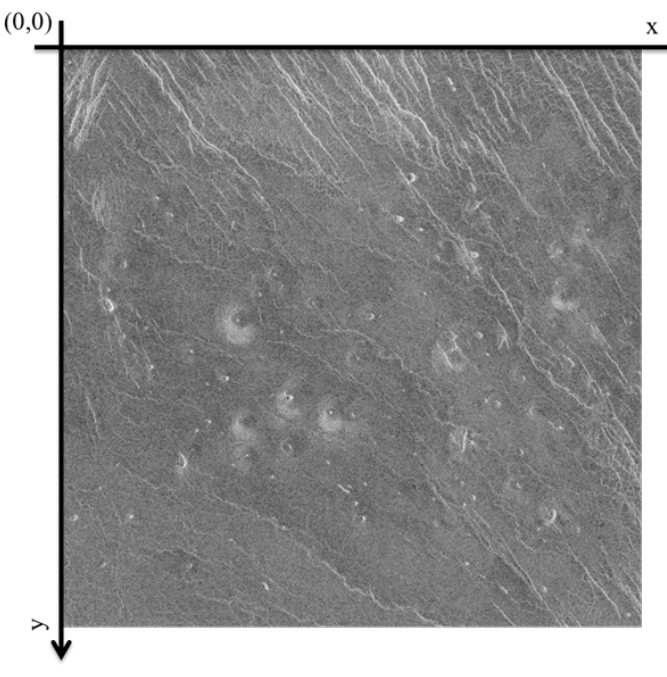
Figure 4. Image coordinate